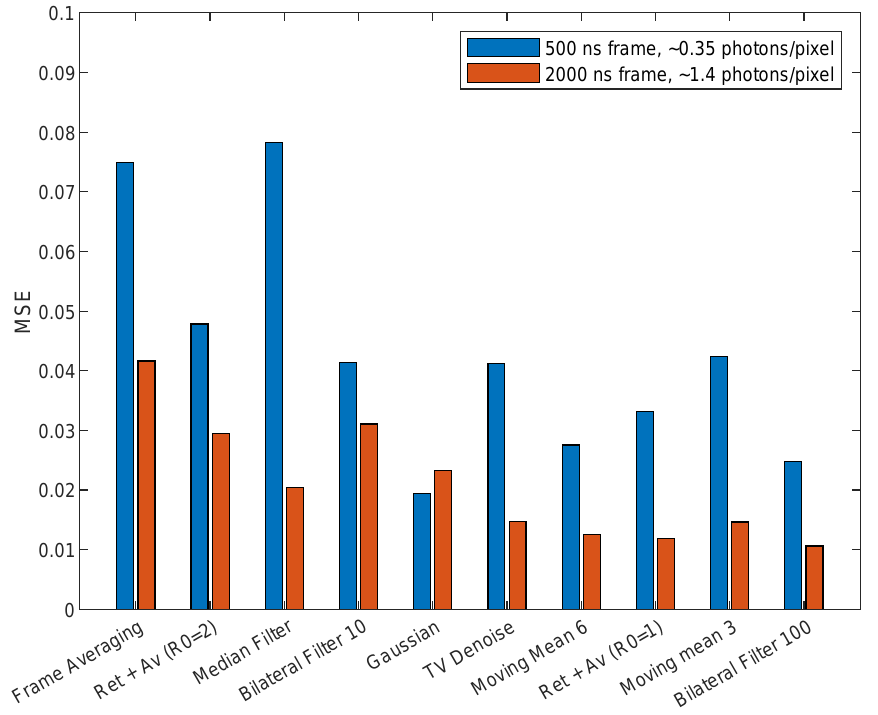
Figure 9. Comparison of the resulting MSE from numerous different reconstruction methods using sparse photon data from the SPAD camera. All methods were tested at both 0.5 µ s and 2.0 µ s total exposure time, corresponding to about 0.35 and 1.4 photons per pixel respectively. Each reconstruction listed was performed 100 times and the displayed image reconstruction quality metric is the mean of these 100 separate reconstructions. Retrodiction and averaging is shown as Ret +